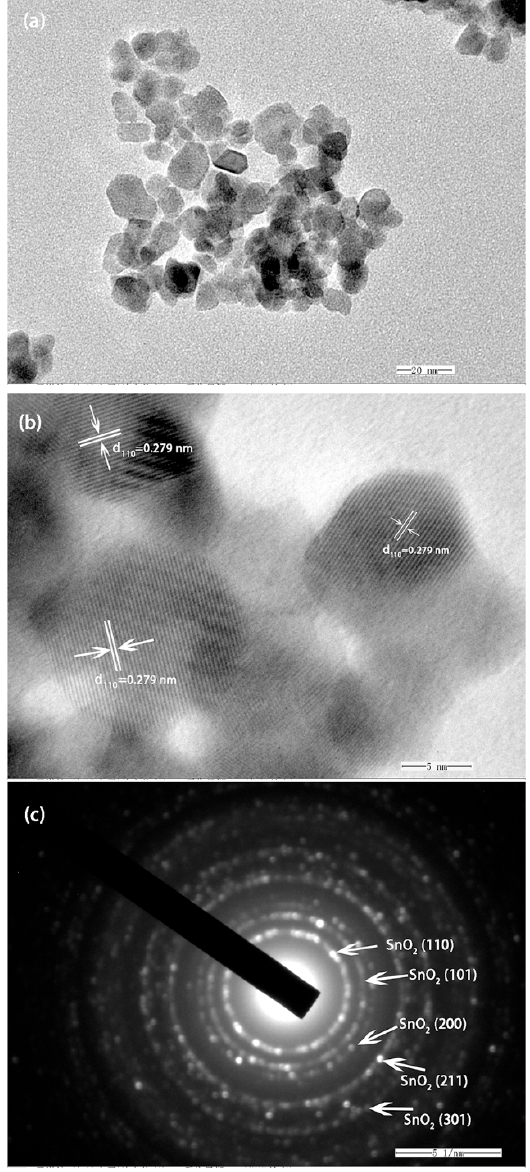
Figure 5. ( a ) TEM image of the SnO 2 ; ( b ) HRTEM image of as-obtained SnO 2 particles; ( c ) The selected area diffraction pattern of SnO 2 particle.